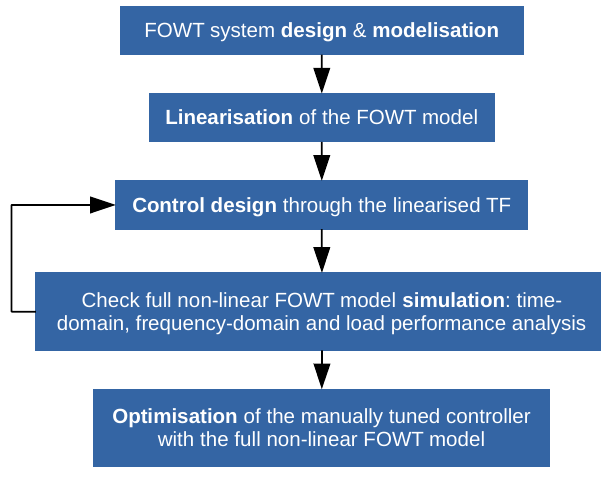
Figure 2. Process carried out for FOWT control